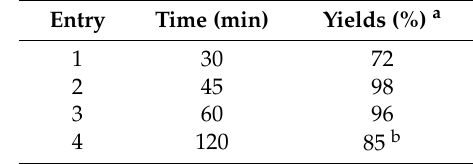
Table 5. Effect of time on product yields. Reaction conditions: 4-toluidine (1 mmol); acetonylacetone